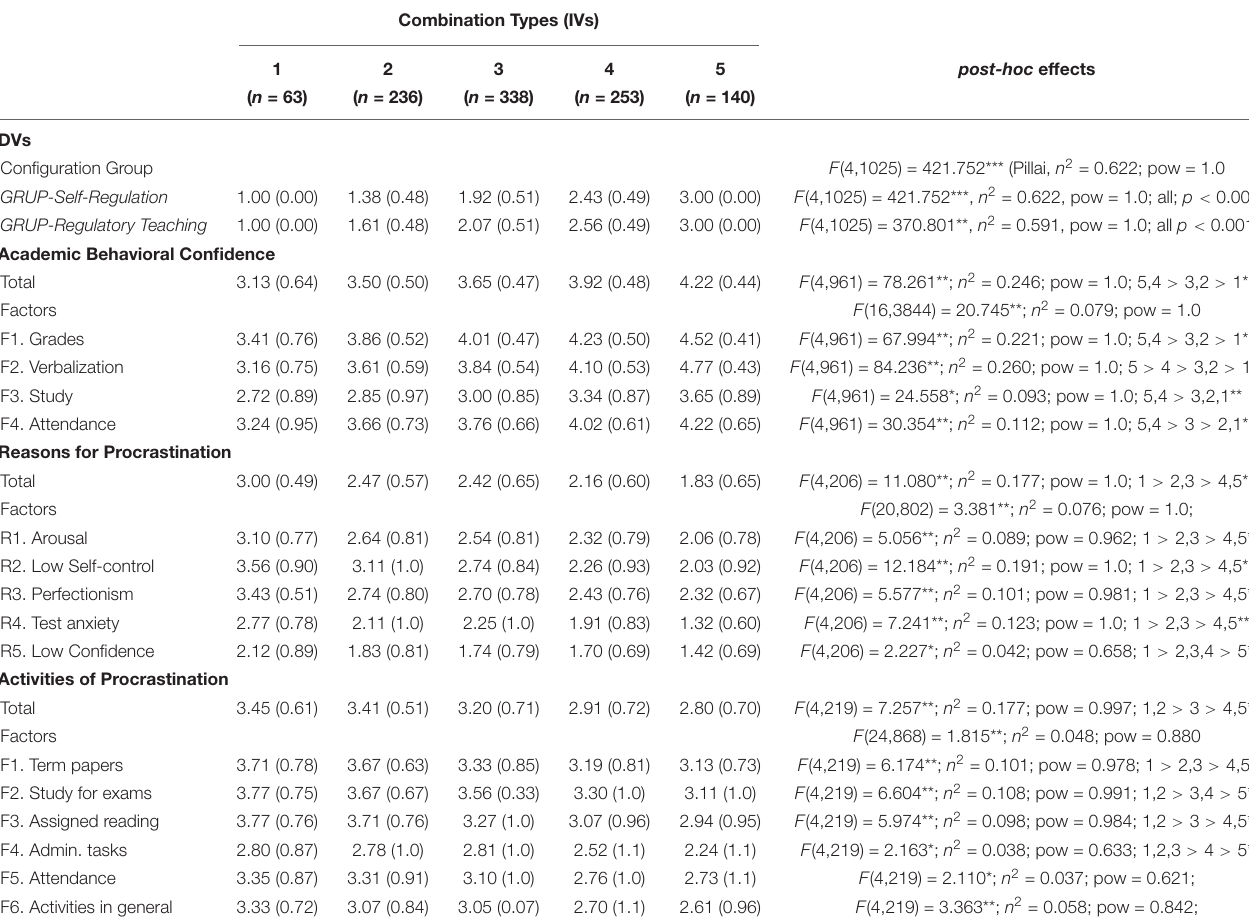
TABLE 3 | Effects of combination types on academic behavioral confidence, procrastination reasons and activities ( n =